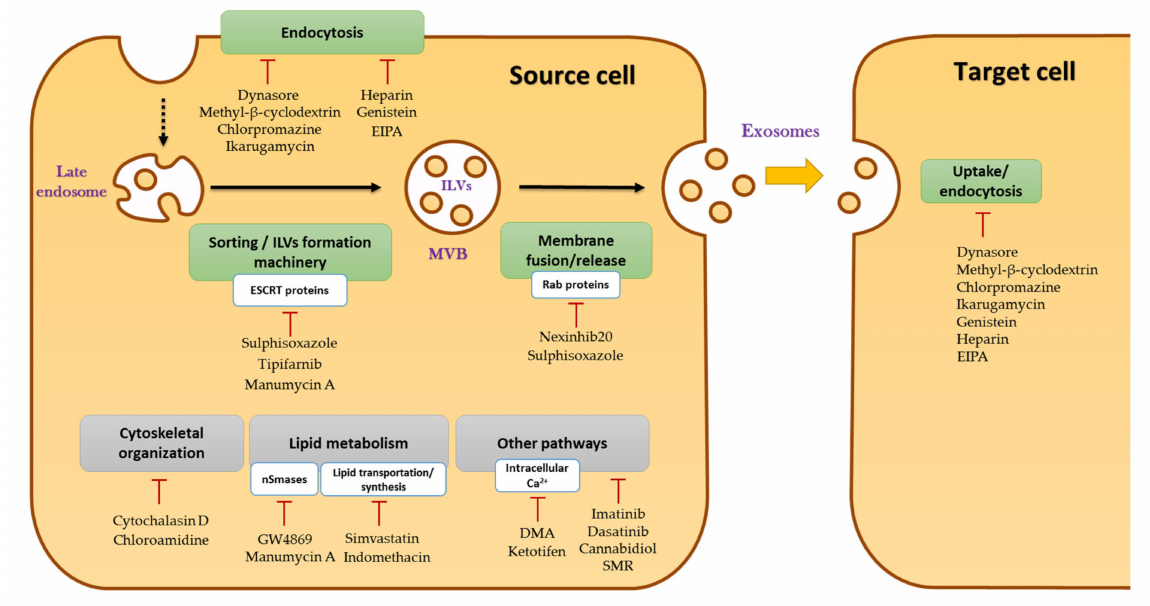
Figure 3. Cellular processes targeted by drugs inhibiting exosome formation/uptake. Cellular processes involved in exosomal biogenesis or uptake targeted by inhibitors are indicated in green inserts, at times accompanied by the specific components that are being targeted, in smaller inserts. Targeted processes affecting cells generally are indicated in grey inserts. Uptake/Endocytosis: Dynasore, Ikarugamycin, and Chlorpromazine target clathrin dependent endocytosis. Methyl- β -cyclodextrin removes the cholesterol from lipid rafts, and affects essentially caveolin-dependent endocytosis, but also clathrin-dependent endocytosis and macropinocytosis. Heparin inhibits cancer cell surface receptors, which depend on heparin sulfate proteoglycan co-receptors for the uptake of exosomes. Genistein is a tyrosine kinase inhibitor that indirectly interferes with the action of actin and dynamin on the plasma membrane necessary for endocytosis. EIPA can inhibit macropinocytosis. Sorting/ILVs formation: Sulphisoxazole, Tipifarnib, and Manumycin A target signaling pathways lead- ing to depletion of ESCRT-dependent components. Membrane fusion: Nexinhib20 and Sulphisoxazole prevent the fusion of MVBs with the plasma membrane and subsequent exosome release, by inhibiting Rab or other proteins. Cytoskeletal organization is important for the membrane topology rearrangements necessary for vesicle formation, trafficking, secretion, and endocytosis. Cytochalasin D inhibits actin polymerization, which prevents trafficking of MVBs toward the plasma membrane, and may also inhibit macropinocytosis. Chloroamidine prevents the post-translational deamination of actin by the protein PAD (peptidylarginine deiminase), which is required for exosome release and uptake. Lipid metabolism is vital for exosome biogenesis and endocytosis. GW4869 and Manumycin A are selective inhibitors of nSMase2 (neutral sphingomyelinase 2), thereby blocking ceramide-mediated exosome biogenesis. Indomethacin reduces expression of the ABCA3 protein involved in lipid transport. Simvastatin, a cholesterol-lowering drug, decreases levels of the exosomal proteins ALIX, CD63, and CD81. Other pathways: Ketotifen (an antihistamine) and Dimethyl Amiloride (DMA) target intracellular calcium levels, important for regulating exosome release. Imatinib and Dasatinib are inhibitors of tyrosine kinases, while Cannabidiol and SMR are peptides found to inhibit EV release in general (adapted from Hayatudin et al., 2021